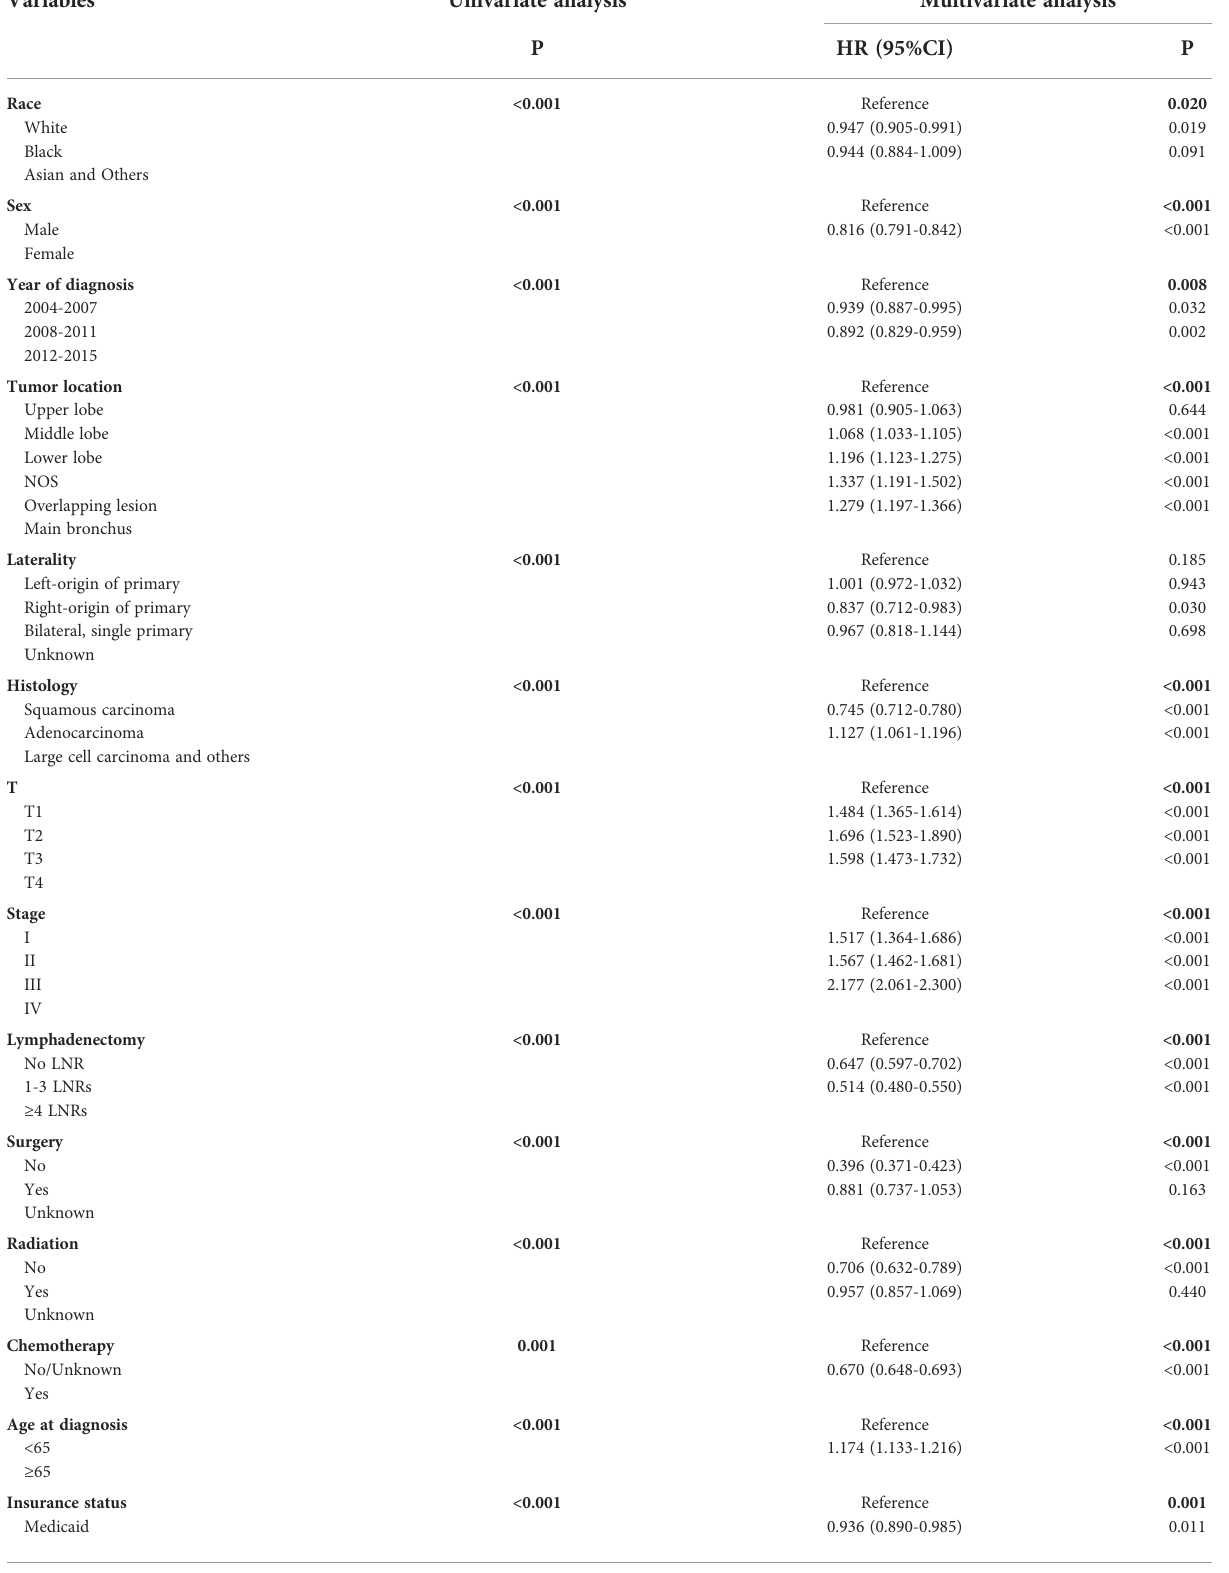
TABLE 4 Univariate and multivariate analyses of LCSS in N0 NSCLC